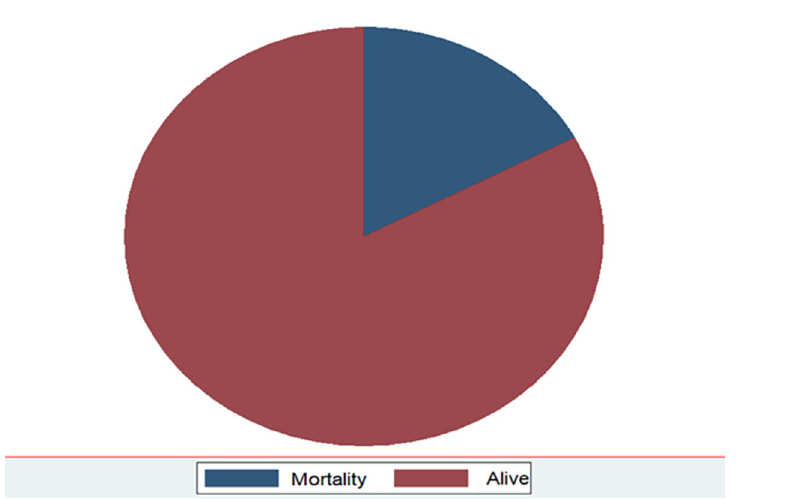
Fig 1. Proportion of mortality among TB and HIV co-infected children by CD4 counts below the threshold level in northwest Ethiopia hospitals, 2021.